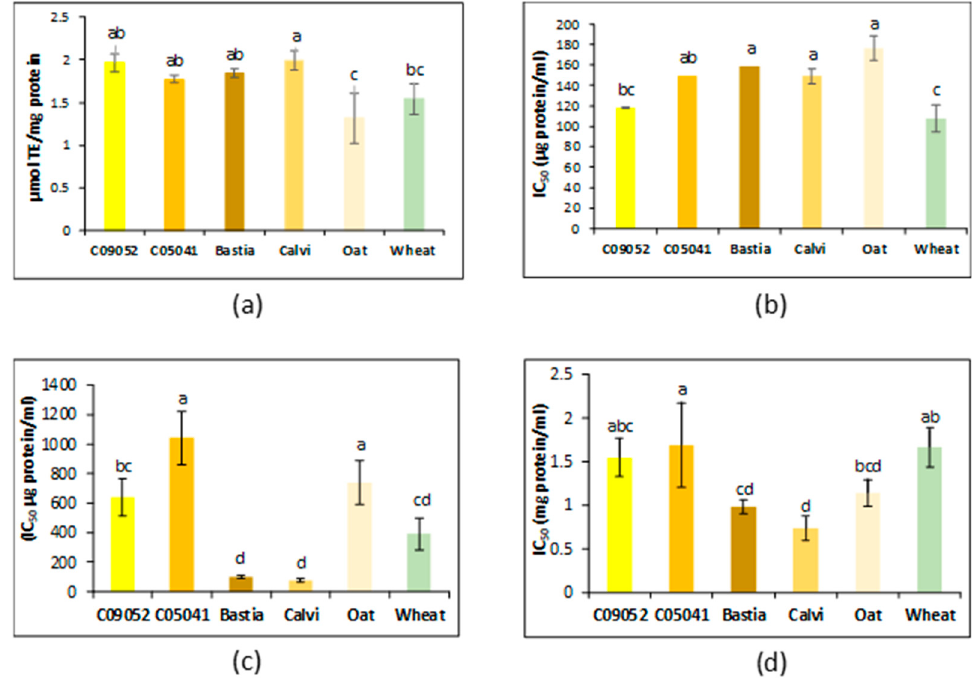
Figure 2. Antioxidant (oxygen radical absorption capacity (ORAC), diammonium salt (ABTS), 2,2-diphenyl-1-picrylhydrazyl (DPPH)) and iron chelation (Fe 2+ ) assays of canary seed, oat and wheat 3K permeates prepared following flours in vitro gastrointestinal digestion and 3-kDa MWCO ultrafiltration. ( a ) ORAC, ( b ) ABTS, ( c ) DPPH, ( d ) Fe 2+ inhibition. IC 50 : inhibitor concentration that